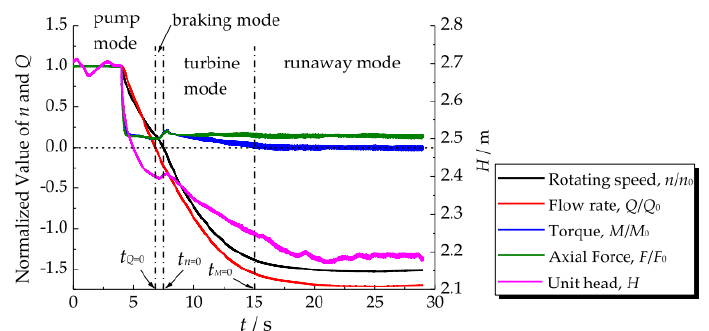
Figure 8. Time history curves of the key dynamic parameters of the pump during the runaway [35]. process.